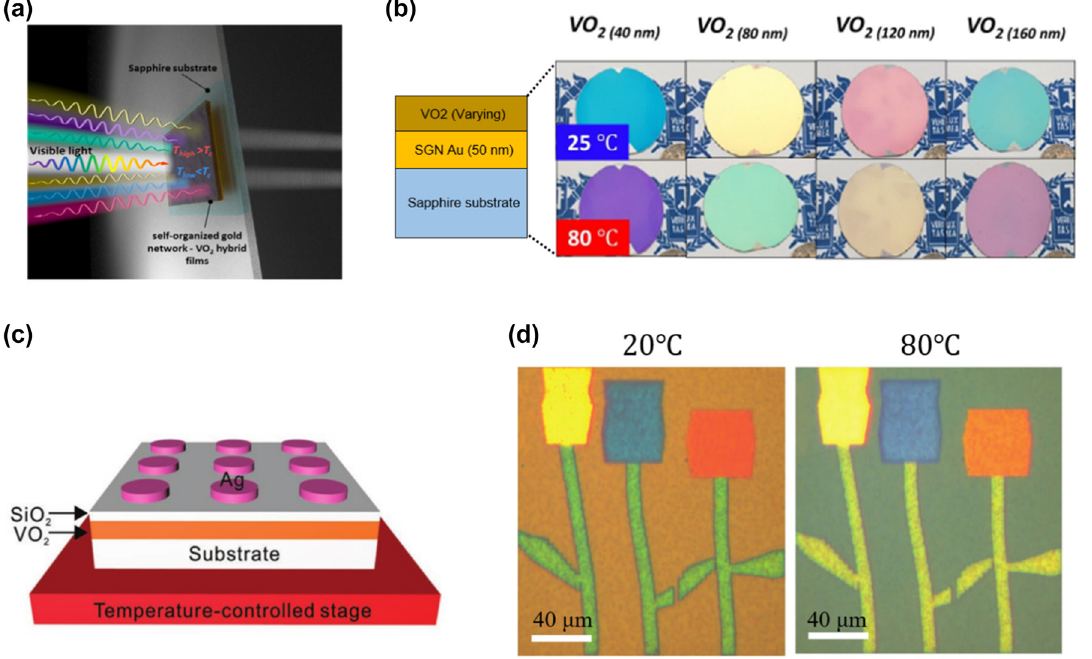
Figure 29: Dynamic structural color generation based on refractive index modulation through external heating. (a) Self-organized gold network–vanadium dioxide hybrid structure for dynamic structural color generation. (b) Photos of the hybrid structures with various VO under different heating temperatures. Modified with permission [308]. Copyright 2020, Wiley-VCH. (c) Schematic diagram of a VO device, composed of a periodic Ag nanodisk array, a SiO at 20 ◦ C and 80 ◦ C. Modified with permission [310]. Copyright 2018,